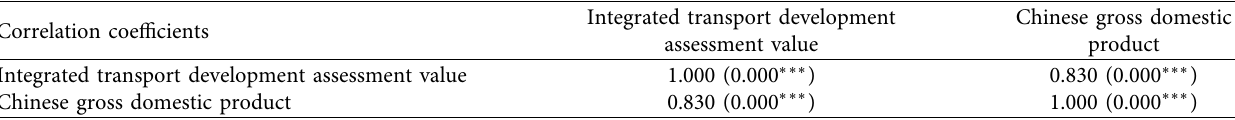
Table 2: National integrated transport development assessment value and GDP correlation coefcient.